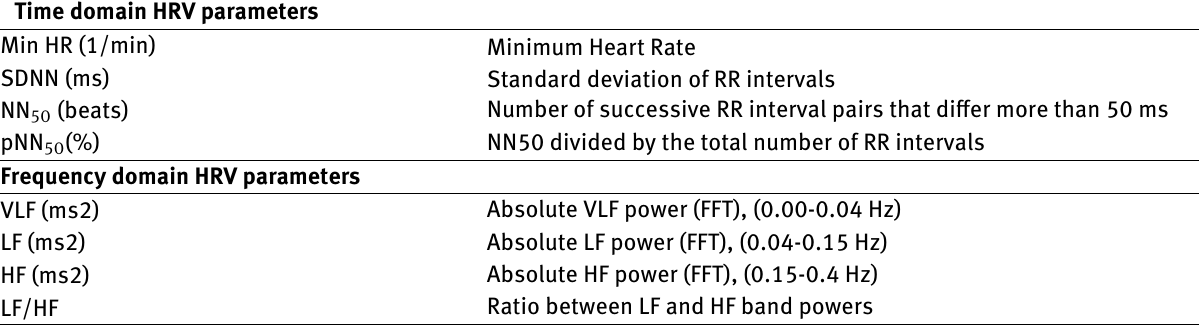
Figure 1: Experimental setup in a listening room (left), Placement of ECG electrodes on participant body (right) (image adopted with permis- sion from shimmersensing.com) Table 1: HRV parameters considered for analysis. Time domain HRV